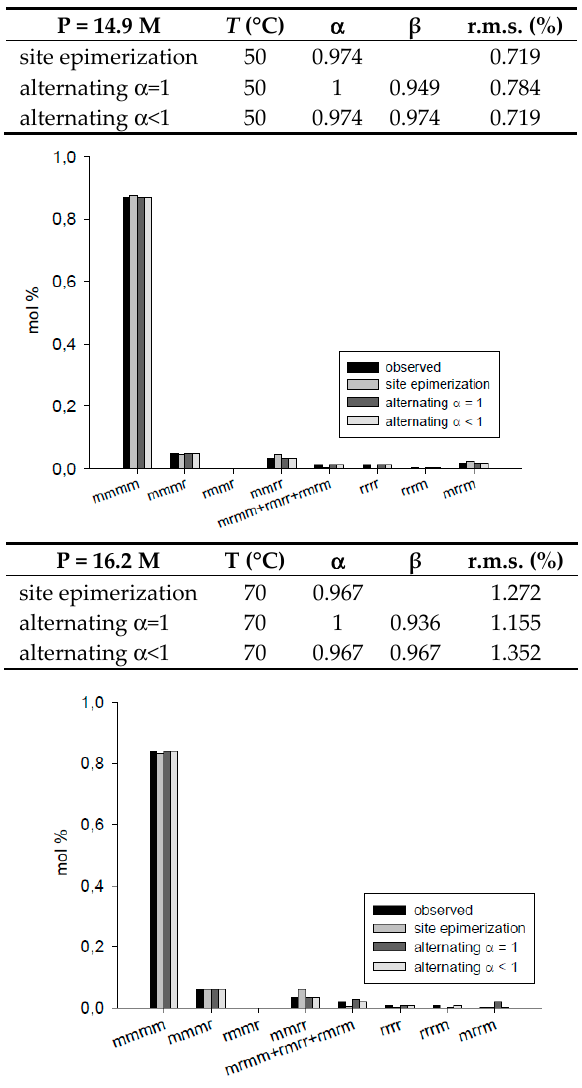
Figure 6. Statistical pentad analysis of a polypropene sample prepared with 3 /MAO at different temperatures.